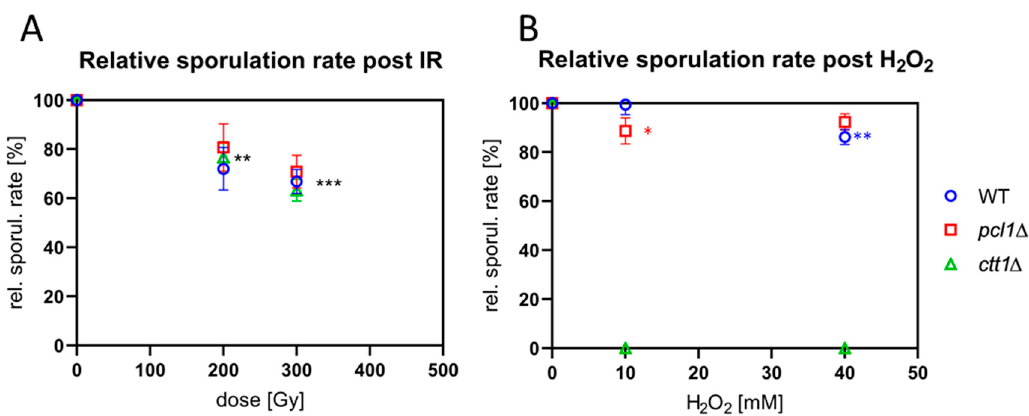
Figure 2. ( A ) X irradiation with 200 and 300 Gy significantly reduced the relative sporulation rate 20 h post-ionizing radiation (IR) relative to the respective non-IR control (** p ≤ 0.0013 and *** p < 0.0001, respectively; ANOVA). ( B ) Wild-type (WT) cells were resistant to 10mM H 2 O 2 treatment, while 40 mM significantly (** p = 0.0012) reduced the average sporulation relative to sham-treated control. The average reduction of sporulation rate was significant for pcl1 ∆ at 10mM (* p = 0.011), while it was not significant post 40 mM H 2 O 2 . In contrast, all H 2 O 2 treatments caused the death of the ctt1 ∆ meiocytes.